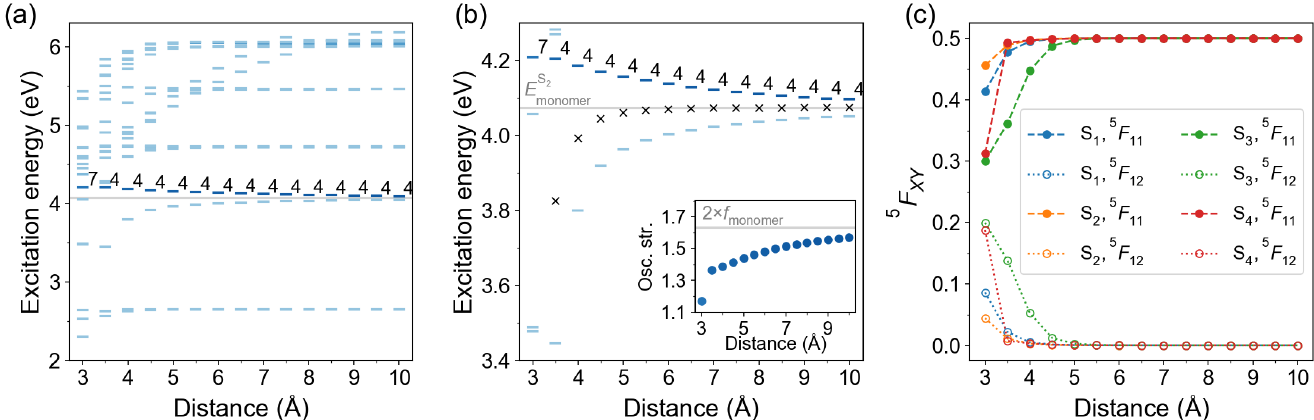
Figure 9. Distance dependence of excitation energies and FTDM matrix elements for π -stacked azobenzene dimers. ( a ) Excitation energies of twenty lowest transitions. The bars are colored according to the oscillator strength of the transitions, with a darker color corresponding to a larger oscillator strength. The bright state labels are printed. The light grey line marks the excitation energy of the bright monomeric transition S 0 → S 2 . ( b ) Excitation energies of the lowest ππ ∗ + E S E S 3 states. Black crosses show the splitting center . The inset shows distance dependence of the oscillator strength of the 4 2 bright transition. The light grey line in the inset marks twice oscillator strength of the monomeric bright transition. ( c ) FTDM matrix elements 5 F 11 and 5 F 12 quantifying local and CT contributions, respectively, for the lowest four electronic